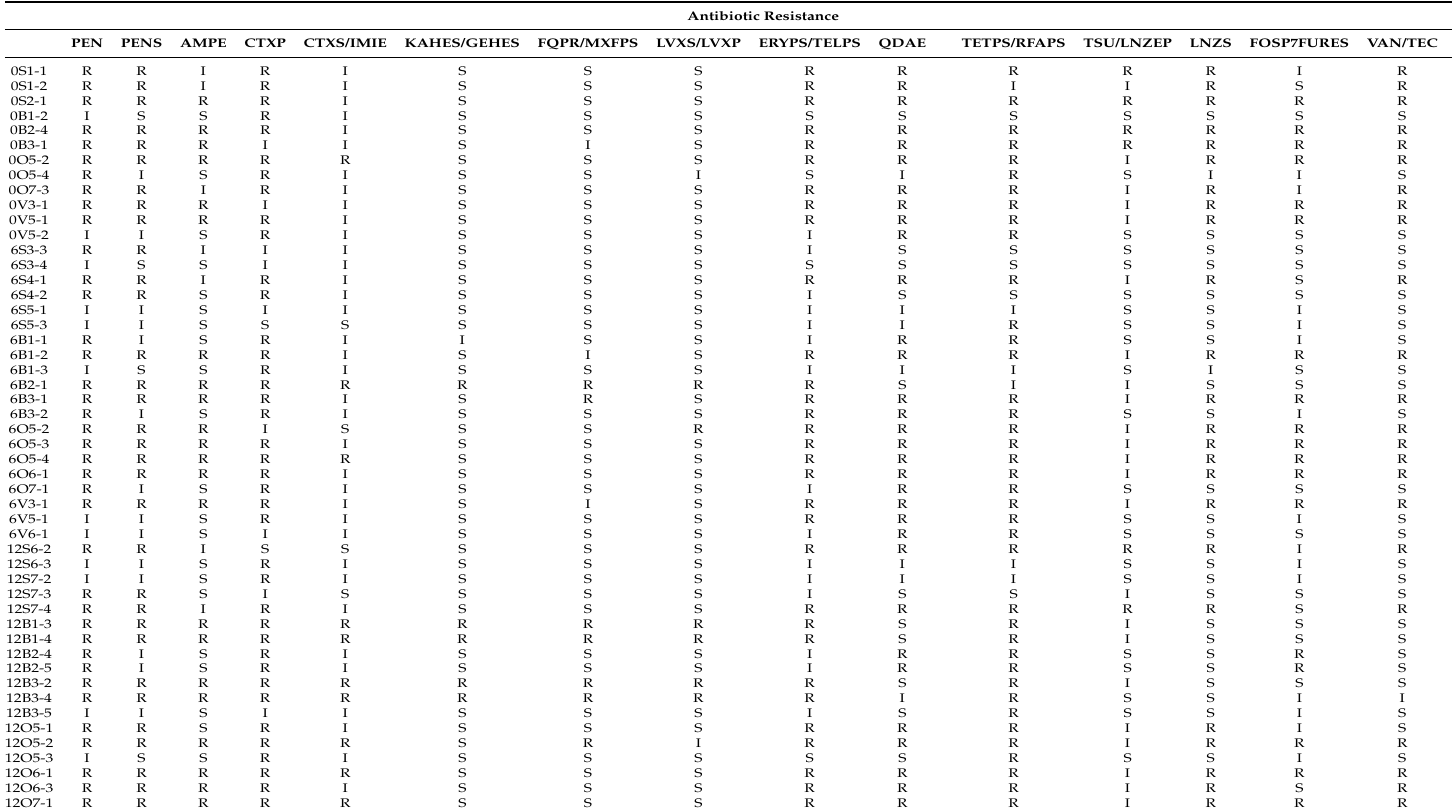
Table 2. Antibiotic resistance. R: Resistant I: Intermediate S: Susceptible. Antibiotics. PENP: penicillin pneumo; PENS: penicillin strepto; AMPE: ampicillin; CTXP: cetofaxim pneumo; CTXS: cetoaxim strepto; IMIE: imipenem; KAHES: kanamycin; GEHES: gentamycin; FQPR: norfloxacin; MXFPS: moxifloxacin; LVXS: levofloxacin strepto; LVXP: levofloxacin pneumo; ERYPS: erythromycin; TELPS: telithromycin; QDAE: quinupristin-dalfopristin; TEPS: tetracyclin; RFAPS: rifampicin; TSU: cotrimoxazol; LNZEP: linezolid pneumo; LNZS: linezolid strepto; FOSP: fosfomycin; FURES: nitrofurantoin; VAN: vancomycin; TEC: teicoplanin. Antibiotic